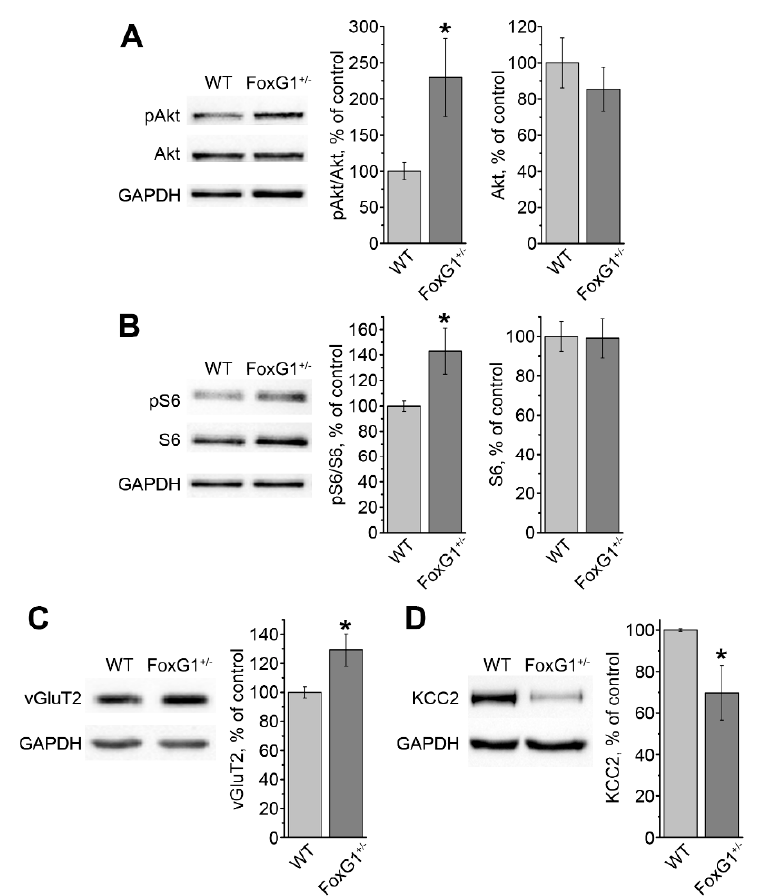
Figure 2. Hyperactivation of the Akt / S6 pathway and dysregulation in the excitatory / inhibitory balance in the cortex of FoxG1 +/ − mice. ( A ) Representative blots and quantifications showing higher Akt phosphorylation in FoxG1 +/ − mice compared to wild type controls (WT) (WT, n = 5; FoxG1 +/ − , n = 5; Student’s t -test, * p ≤ 0.05); ( B ) representative blots and quantification showing higher S6 phosphorylation in FoxG1 +/ − mice compared to wild type controls (WT) (WT, n = 5; FoxG1 +/ − , n = 5; Student’s t -test, * p ≤ 0.05); ( C ) representative blots and quantification showing higher vGluT2 expression in FoxG1 +/ − mice compared to wild type controls (WT) (WT, n = 5; FoxG1 +/ − , n = 5; Student’s t -test, * p ≤ 0.05); ( D ) representative blots and quantification showing lower KCC2 expression in FoxG1 +/ − mice compared to wild type controls (WT) (WT, n = 5; FoxG1 +/ − , n = 5; Student’s t -test, * p ≤ 0.05).